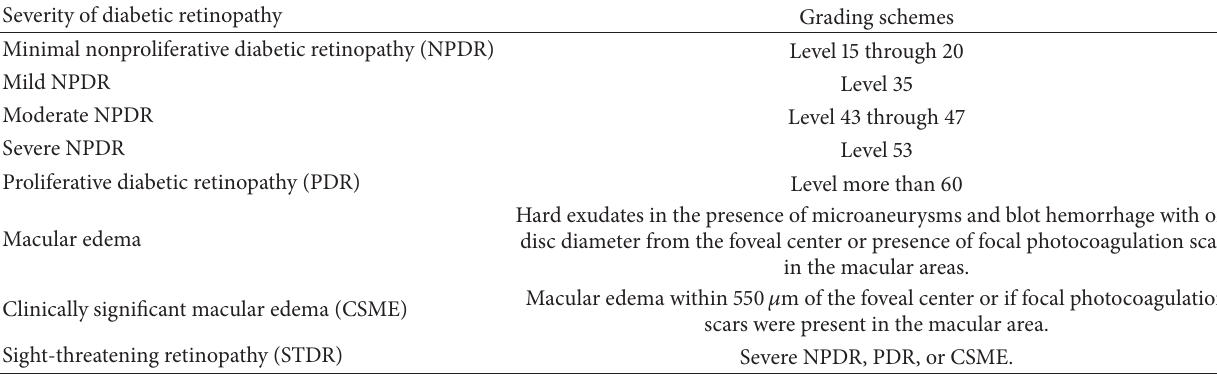
Table 1: Grading schemes of diabetic